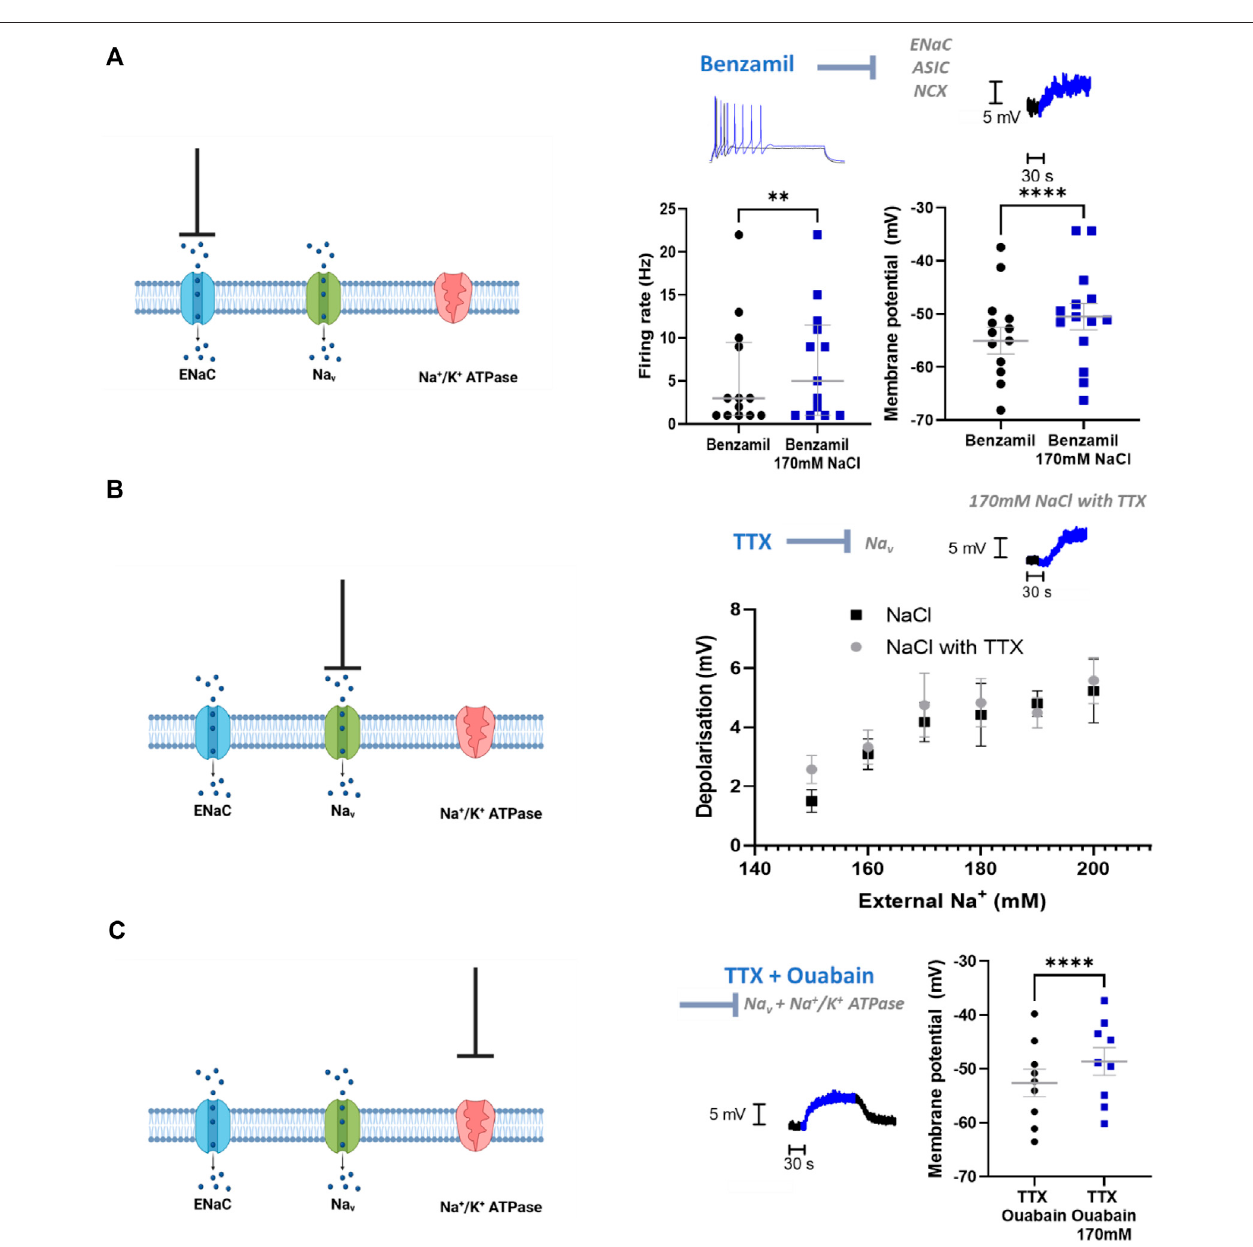
FIGURE 3 | ENaCs, Na v and Na + /K + ATPase do not contribute to the NaCl response in stellate ganglia neuron. (A) 1 µM Benzamil does not prevent NaCl induced fi ring rate increases or membrane depolarization in stellate ganglia neurons. In the presence of 1 µM Benzamil 170 mM NaCl still increased maximum fi ring rate (3 Hz – 5 Hz; n= 13;Wilcoxon test; p = 0.0078) and caused adepolarization (4.55 ±0.55 mV;n =14; Paired t -test; p < 0.0001). Forthe raw datatrace, 1 µM Benzamil with physiological[NaCl] o isshowninblack,and1 µMBenzamilwith170 mM[NaCl] o isshowninblue. (B) TTXhadnoeffectuponmembranedepolarizationinducedby 150 – 200 mM NaCl in stellate ganglia neurons There was no signi fi cant difference between membrane depolarization induced by NaCl in the presence or absence of 1 µMTTX.Forrawdatatrace,physiologicalextracellularNa+showninblackand170 mMNaClwithTTXisshowninblue(Control,n=15 – 22;1 µMTTX,n=7 – 13;Two- way ANOVA; p = 0.42). (C) TTX and ouabain did not prevent 170 mM NaCl induced depolarization. 170 mM NaCl caused a signi fi cant depolarization of sympathetic neurons in the presence of both 1 µM TTX and 100 µM Ouabain relative to 1 µM TTX and Ouabain alone (3.98 ± 0.48 mV; n = 9; Paired t -test; p < 0.0001). On the raw data trace, baseline and washout are shown in black, 170 mM NaCl is shown in blue.